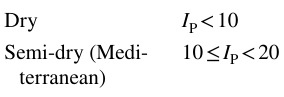
Table 3 Climate according to the Pinna combinative index (Moral et al. 2015)